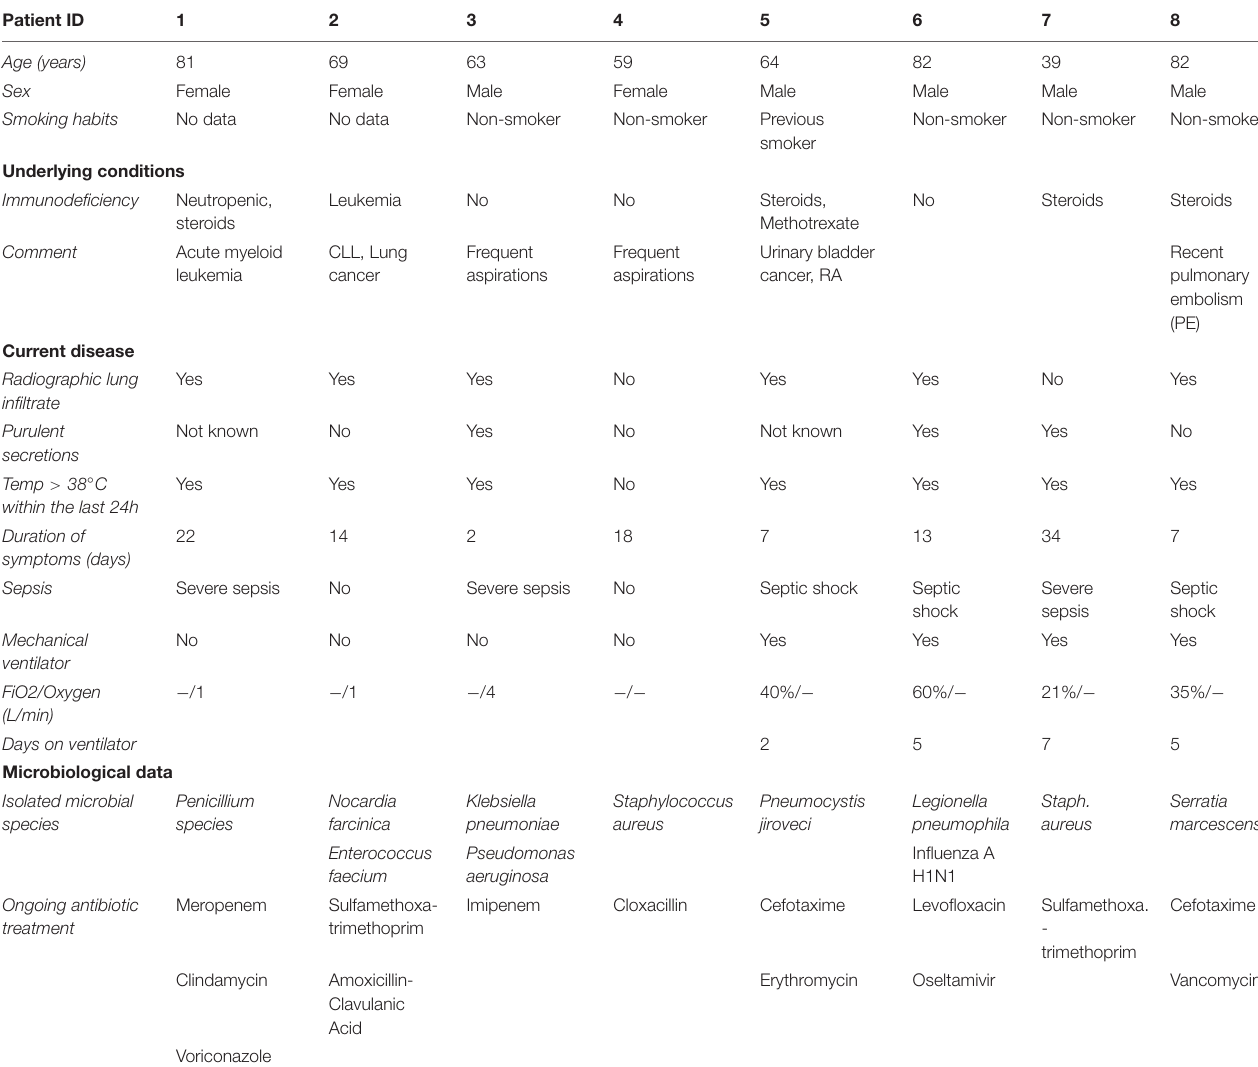
TABLE 1 | Demographic and microbiological data of